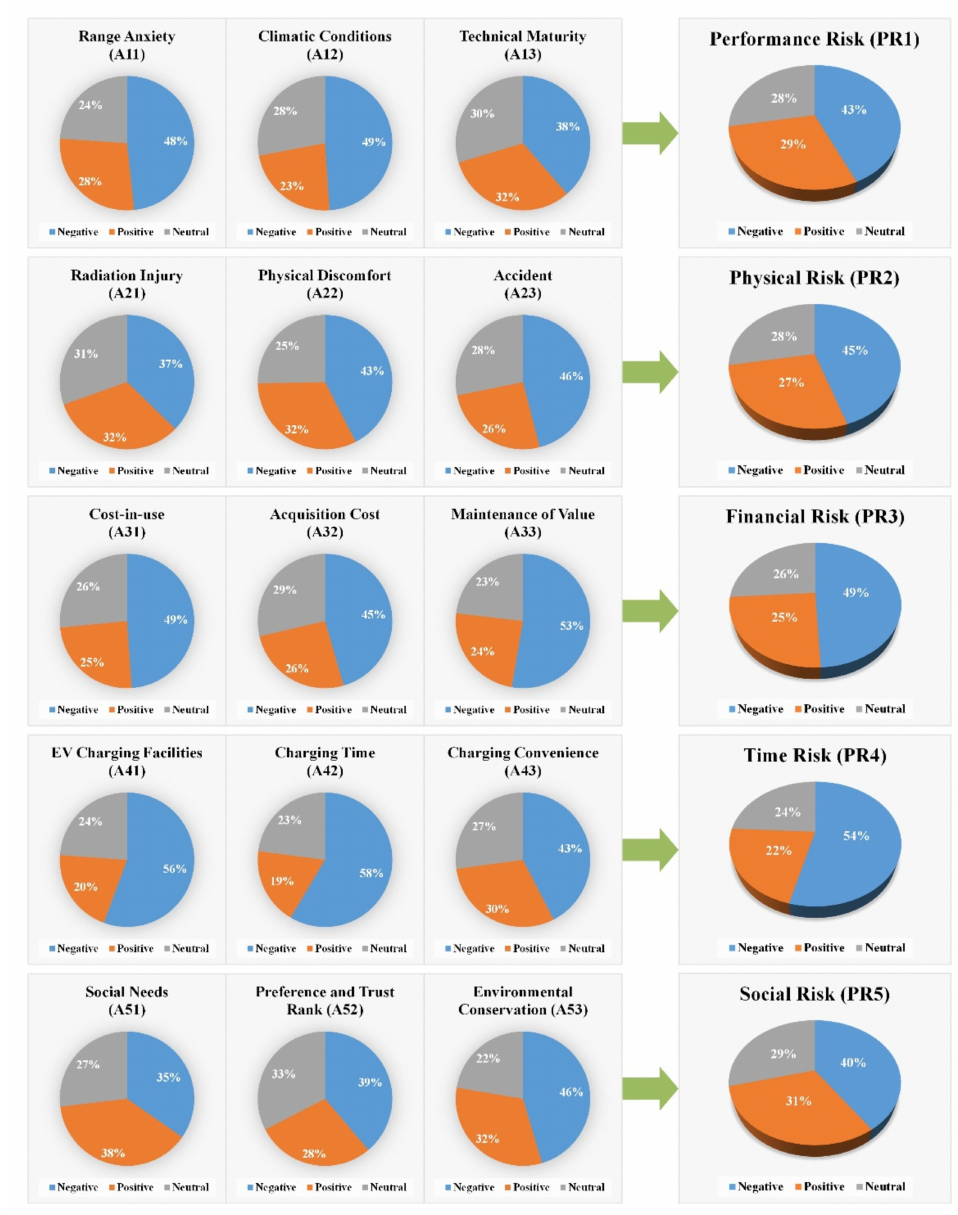
Figure 7. Emotion Pie Graph of Customer towards